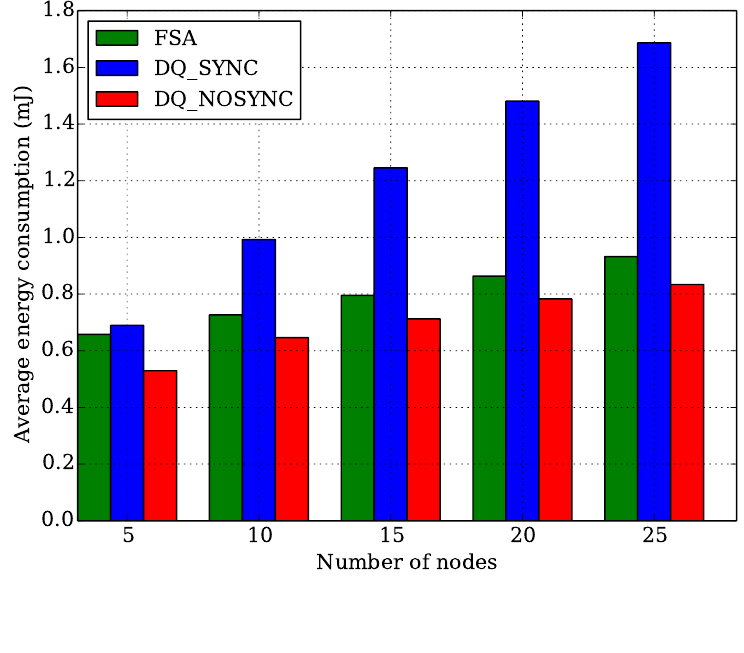
Figure 9. Energy consumption of Frame Slotted ALOHA (FSA) and Distributed Queuing (DQ) with both synchronization and no synchronization. Reducing the number of FBP required to maintain synchronization leads to a reduction in energy consumption that makes DQ more energy efficient and easier to implement than